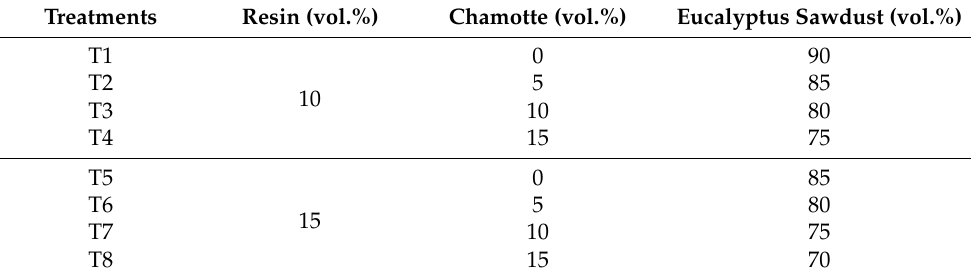
Table 2. Experimental formulations to produce panels by hot pressing. Treatments Resin (vol.%) Chamotte